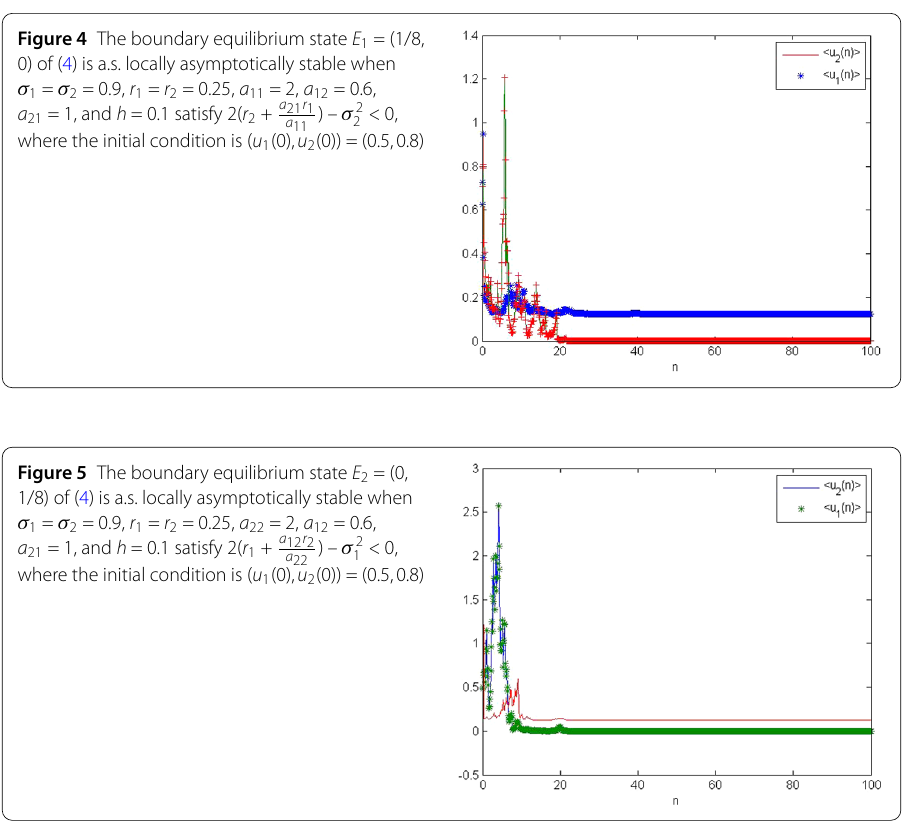
Figure 4 The boundary equilibrium state E 1 = (1/8, 0) of (4) is a.s. locally asymptotically stable when